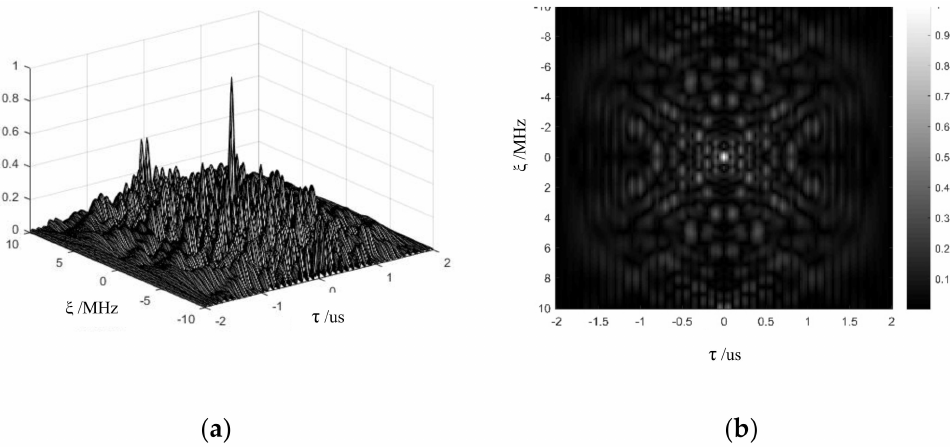
Figure 4. FSK-PSK signal ambiguity function. ( a ) FSK-PSK signal ambiguity function. ( b ) FSK-PSK signal ambiguity diagram.